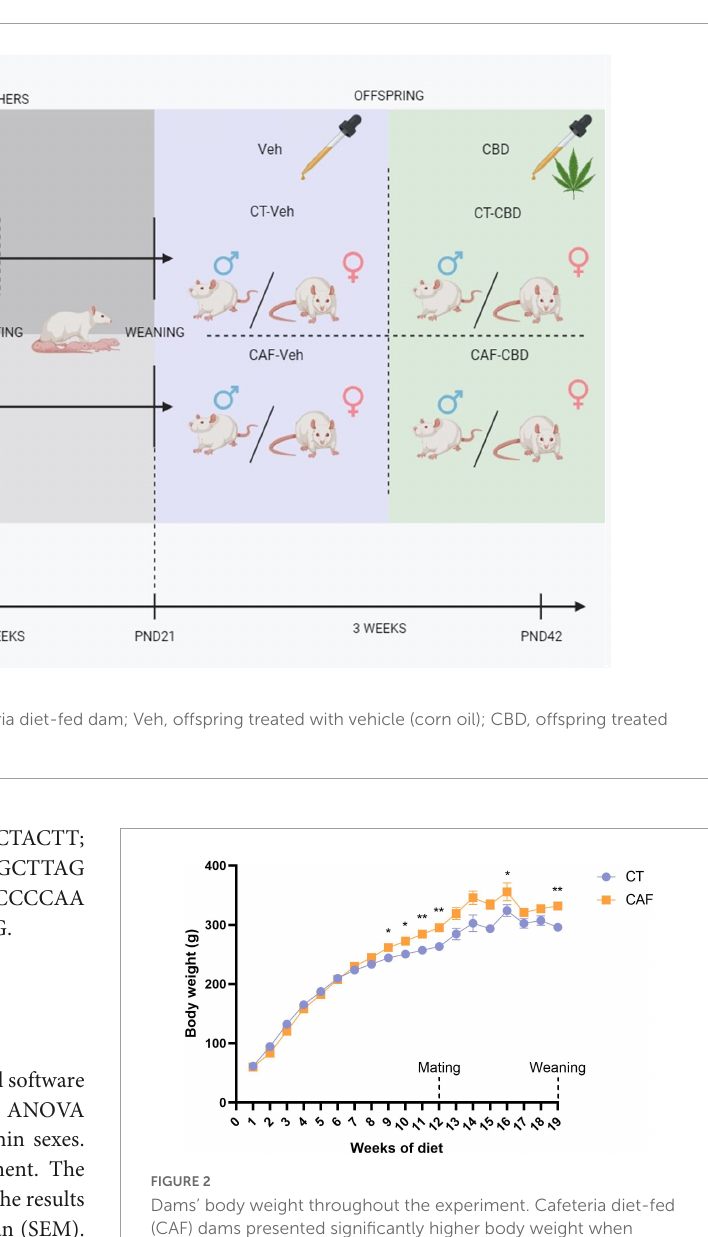
FIGURE2 Dams’ body weight throughout the experiment. Cafeteria diet-fed (CAF) dams presented significantly higher body weight when compared to control diet (CT) from the 9th week of diet, which was consistent until mating (12th week of diet) and after weaning of the offspring (19th week of diet). Data are presented as mean ± SEM. n = 9/group. * p < 0.05 ** p <